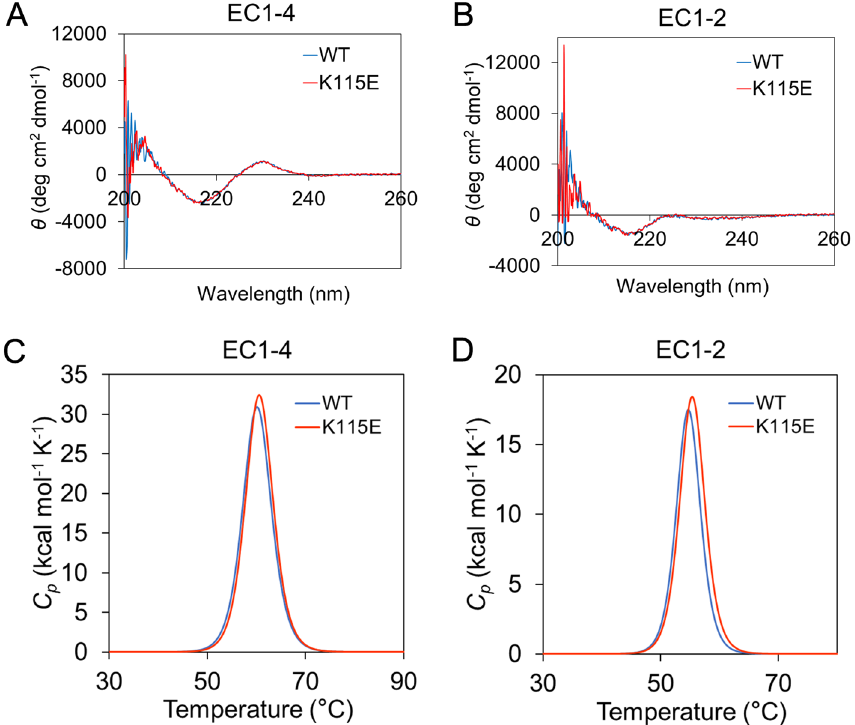
Figure 4. Structural comparison of WT and K115E in vitro. ( A ) Circular dichroism (CD) spectra of EC1-4WT and EC1-4K115E. ( B ) CD spectra of EC1-2WT and EC1-2K115E. ( C ) Thermal stability analysis of EC1-4 WT and EC1-4 K115E. ( D ) Thermal stability analysis of EC1-2 WT and EC1-2